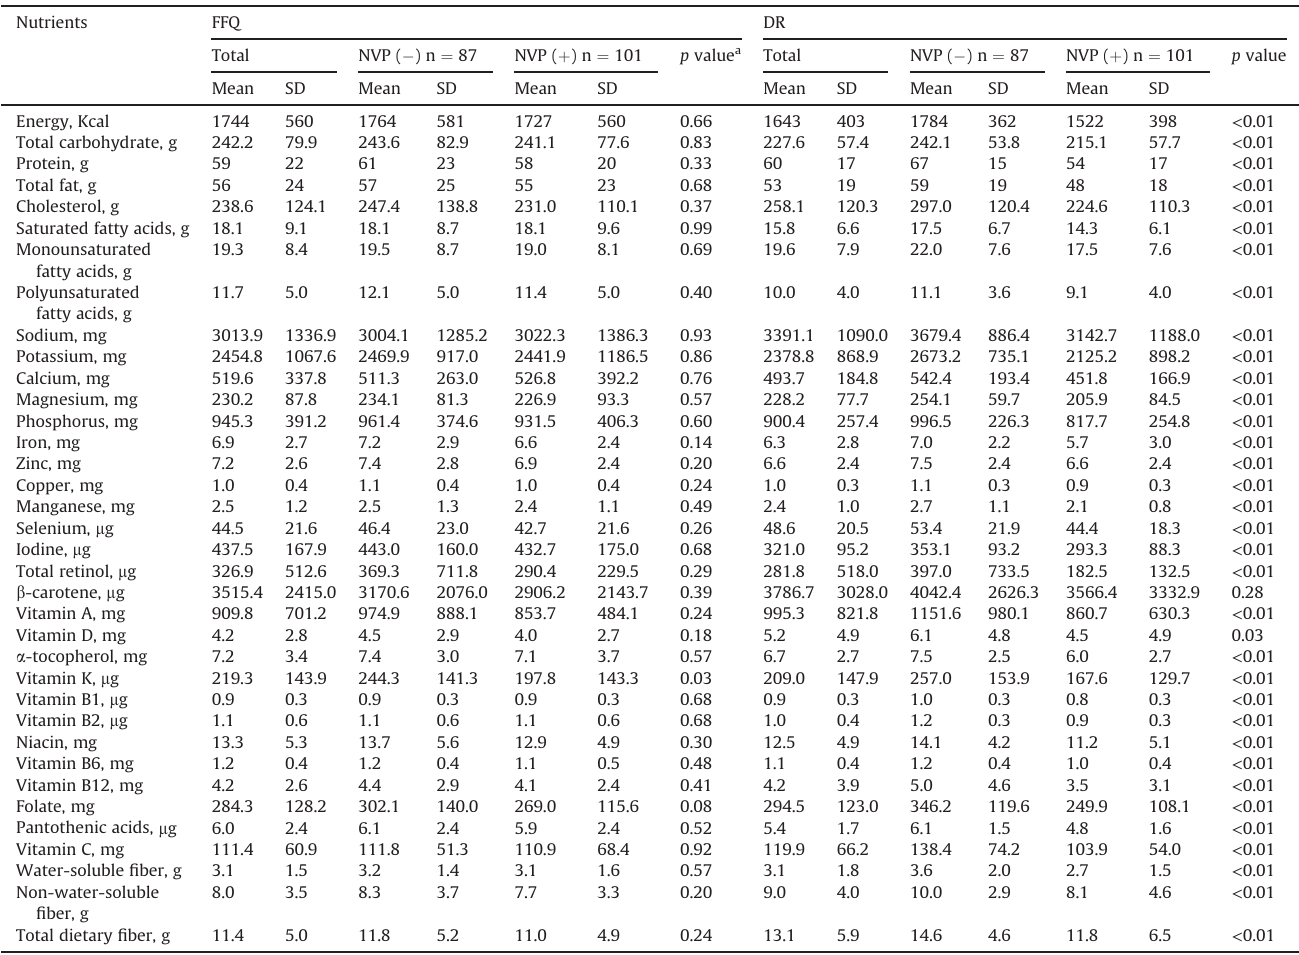
Table 2 Estimated mean intakes of nutrients from DR and FFQ. Nutrients FFQ